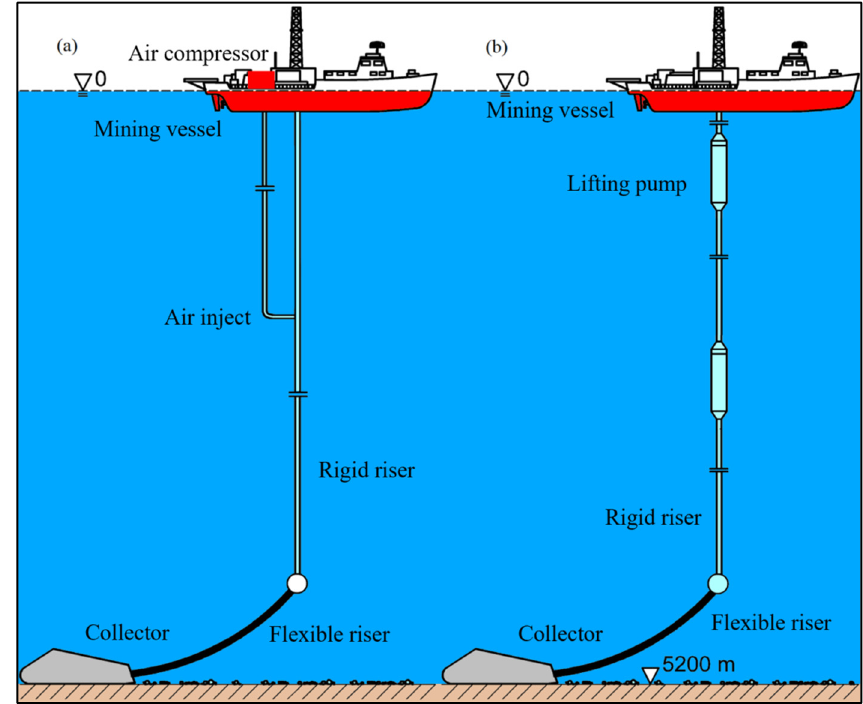
Figure 1. OMI pilot mining system configuration ( a ) air lift system ( b ) pump lift system.